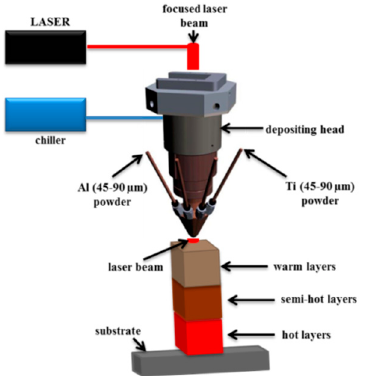
Figure 1. Schematic representation of the Laser Engineered Net Shaping (LENS) set-up.